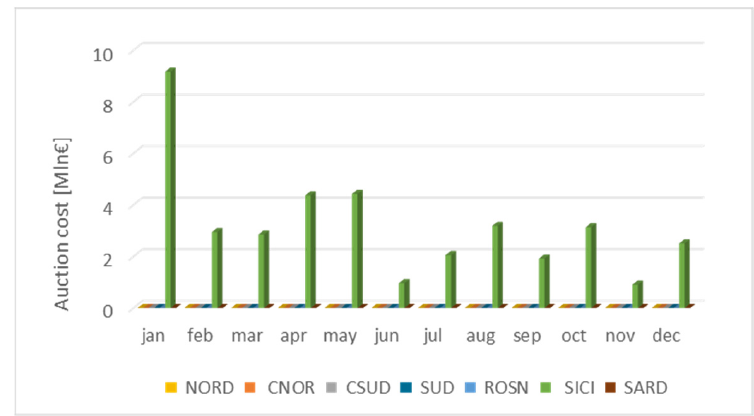
Figure 9. Auction cost in the different market